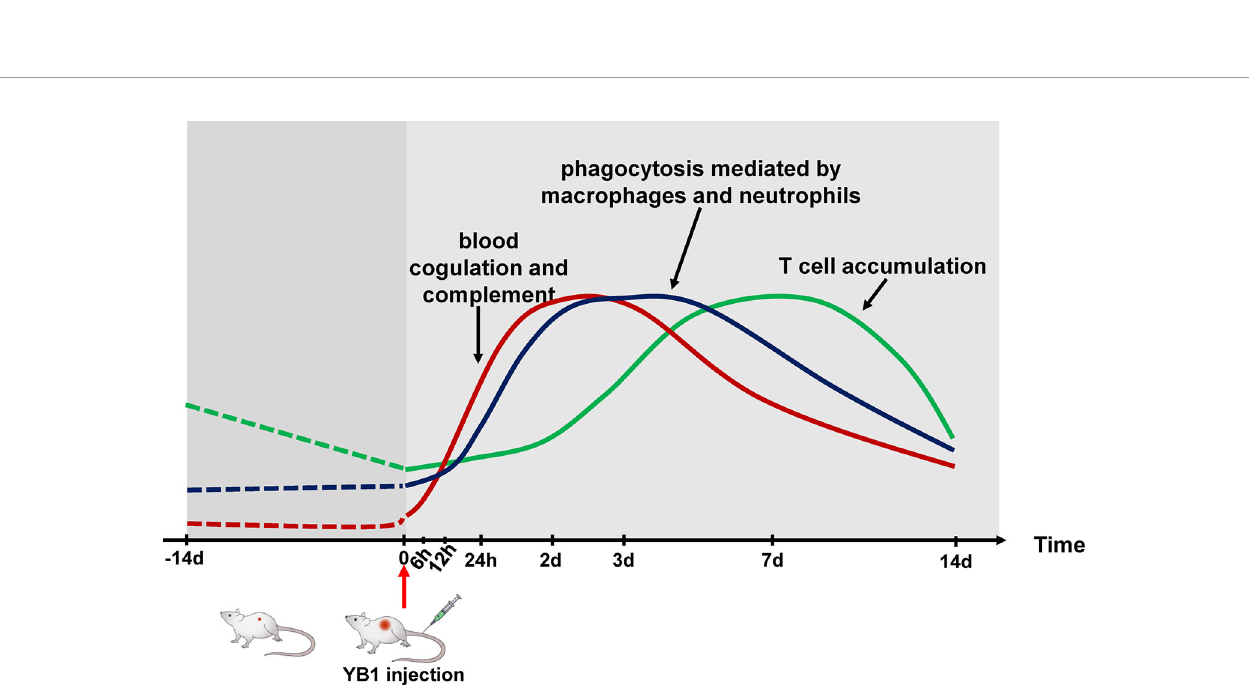
FIGURE 6 | Schematic temporal dynamics of the immunological offensive triggered by YB1 treatment. The red line represents the blood coagulation and complement. The blue line represents phagocytosis mediated by macrophages and neutrophils. The green line represents T cell accumulation in the invasion margin.